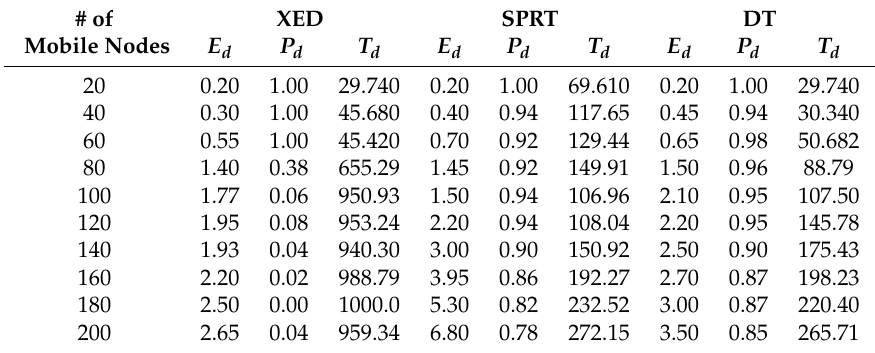
Figure 17. Comparison in terms of energy consumption. Table 1. Node replication attacks performance comparison considering distributed, centralized and hybrid